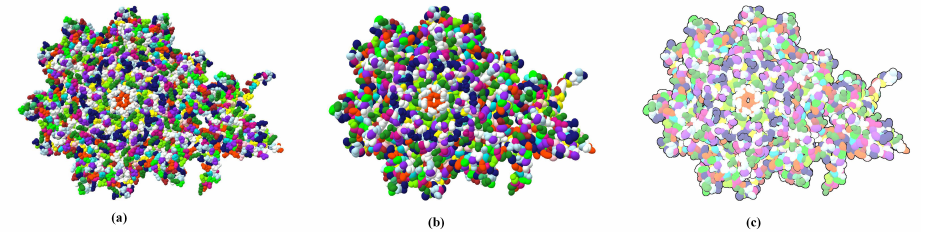
Figure 10. A comparison between the original van der Waals surface ( a ) and the hierarchical ellipsoid surface ( b ) of a protein (ID: 1OHG). The overall shape of the protein and the via hole are clearly preserved. The abstract surface ( c ) with diffuse shading and contours hides surface error caused by